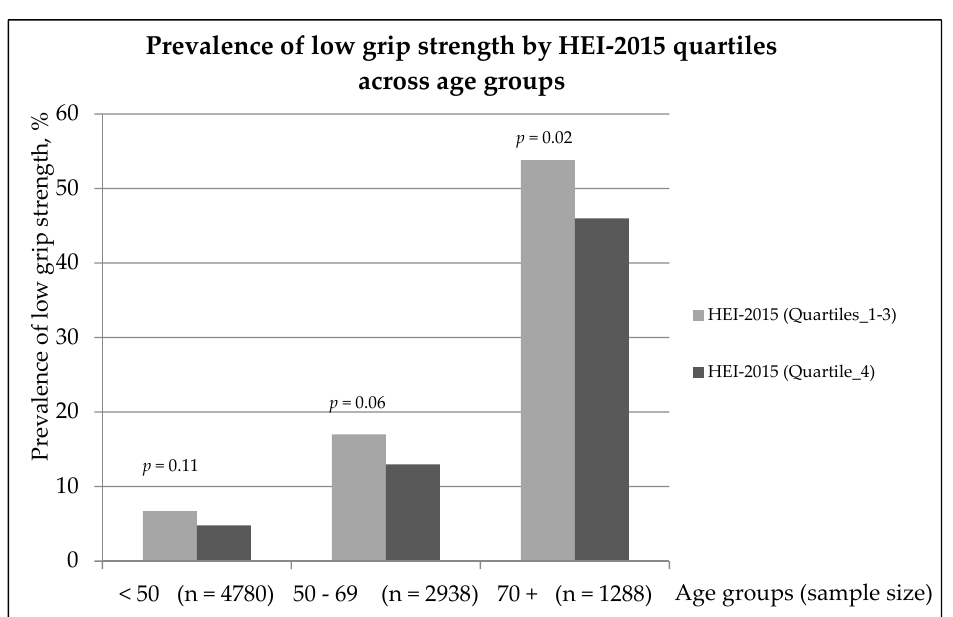
Figure 1. Low grip strength prevalence by HEI-2015 quartiles across age groups .